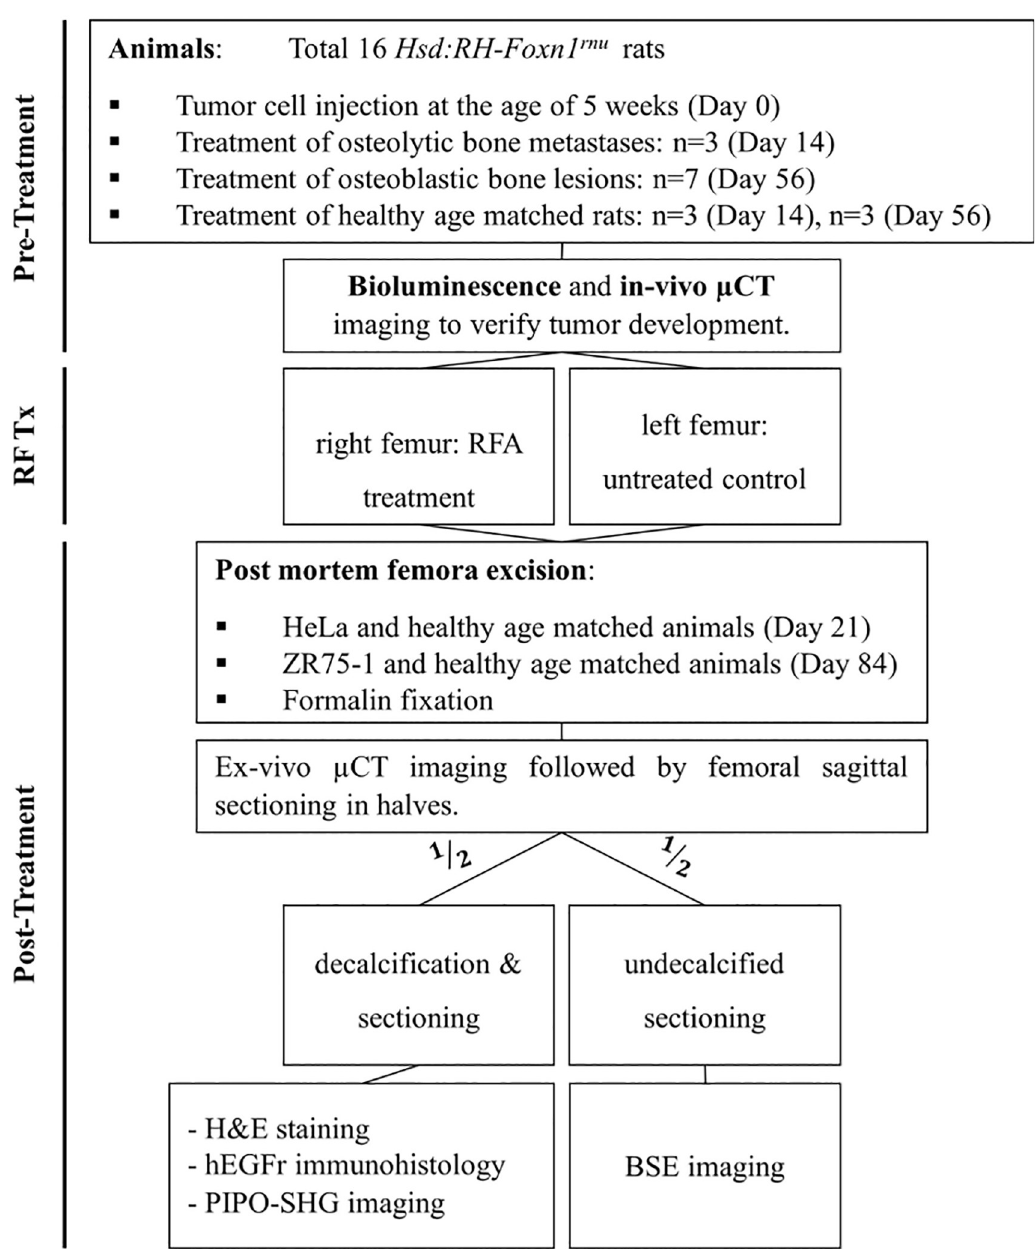
Fig 1. Experimental design and workflow. Micro computer tomography ( μ CT); radiofrequency ablation treatment (RF Tx); radiofrequency ablation (RFA); hematoxylin and eosin (H&E); human epithelium growth factor receptor (hEGFr); polarization- in, polarization-out (PIPO) second harmonic generation (SHG); backscatter electron (BSE).